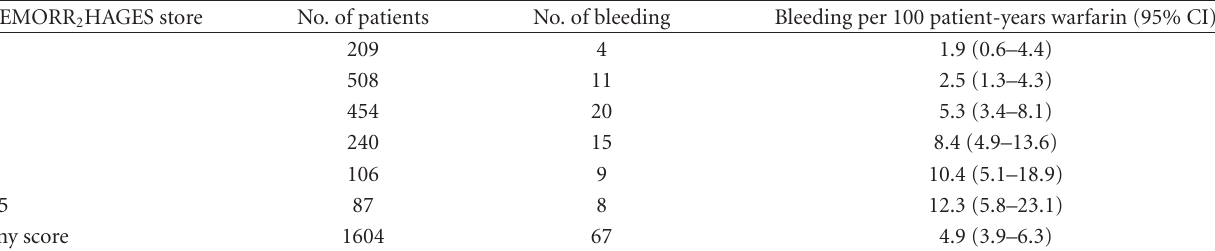
Table 3: Incidence of major bleeding stratified by the HEMORR 2 HAGES score (data from the National Registry of Atrial Fibrillation). HEMORR 2 HAGES